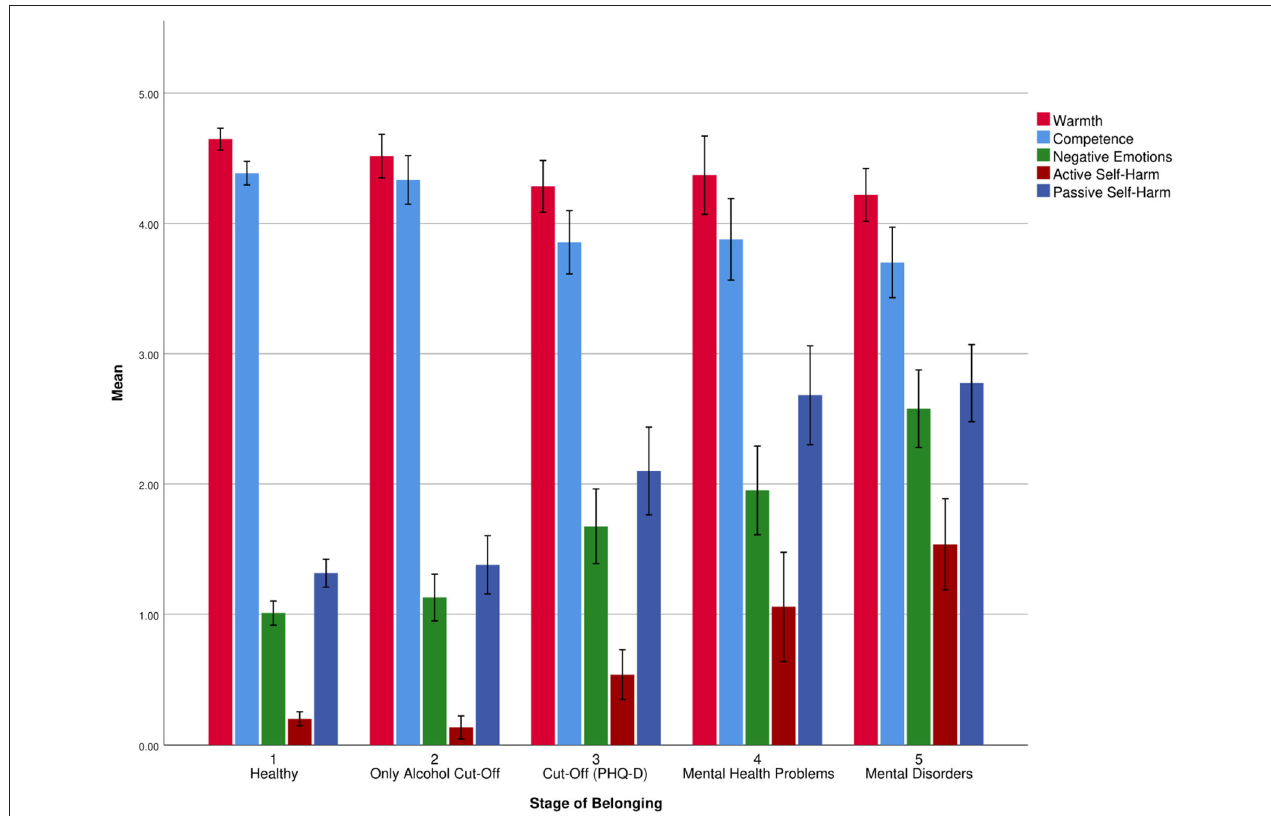
FIGURE 3 | Means and error bars (95% CI) of warmth, competence, negative emotions, active self-harm, and passive self-harm for each stage of belonging, referring to the process of